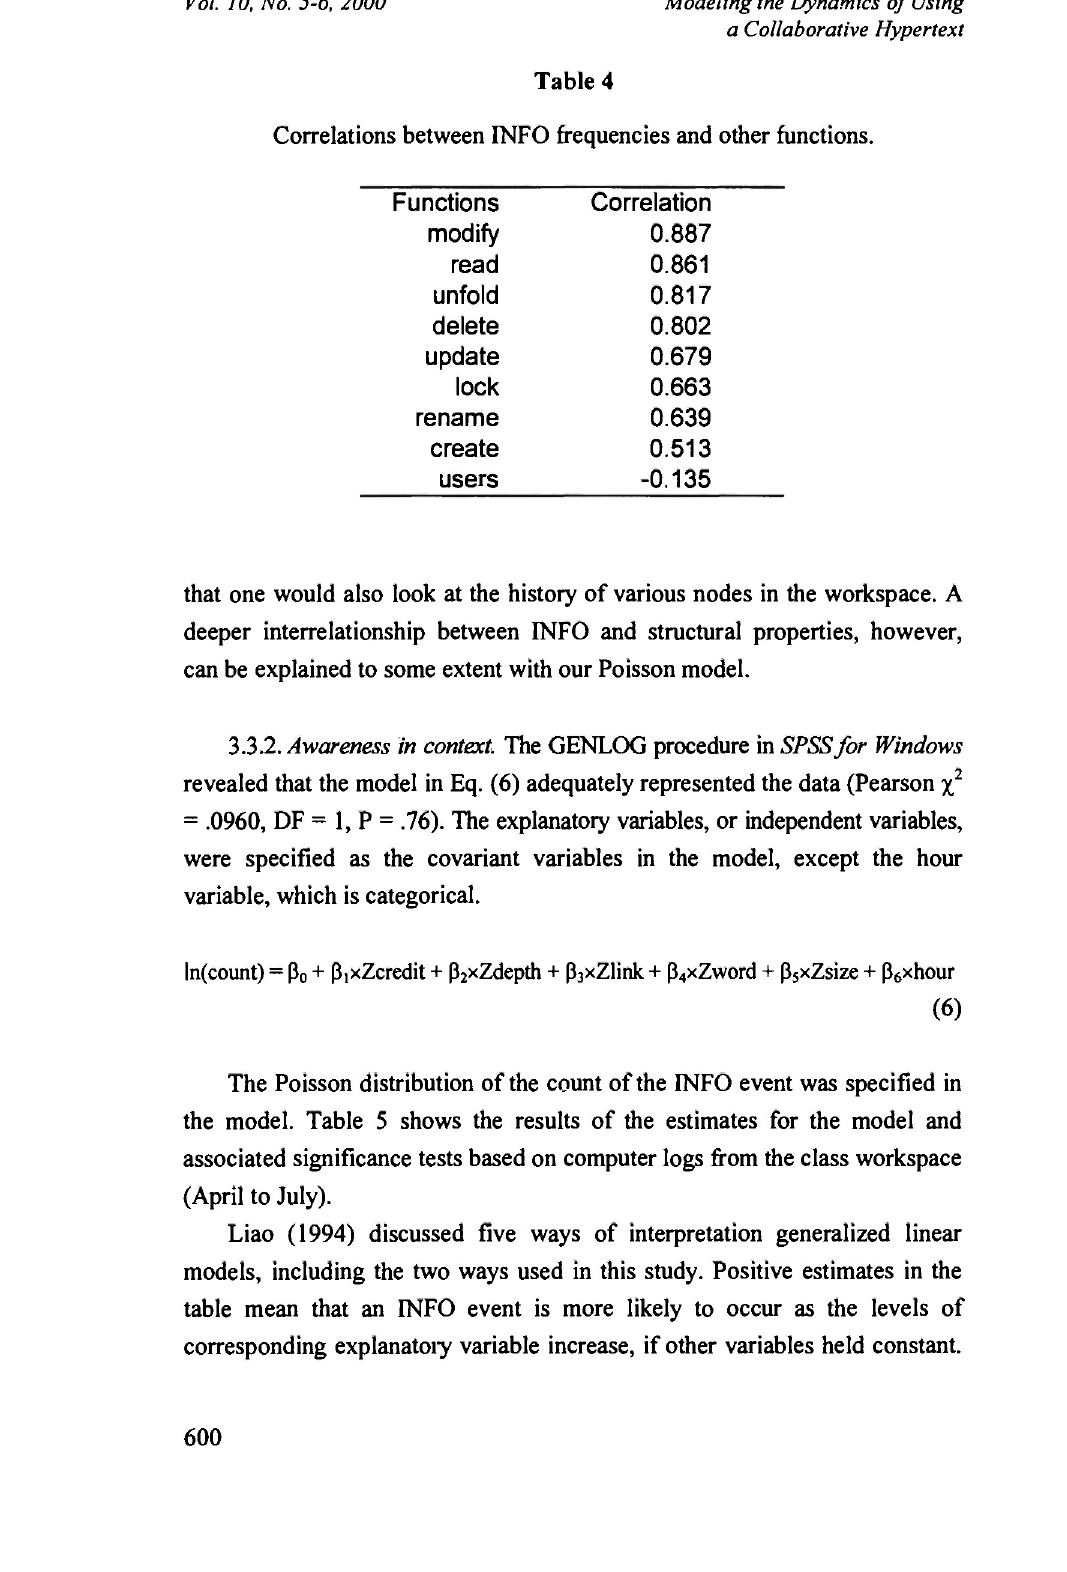
Correlations between INFO frequencies and other functions. Functions